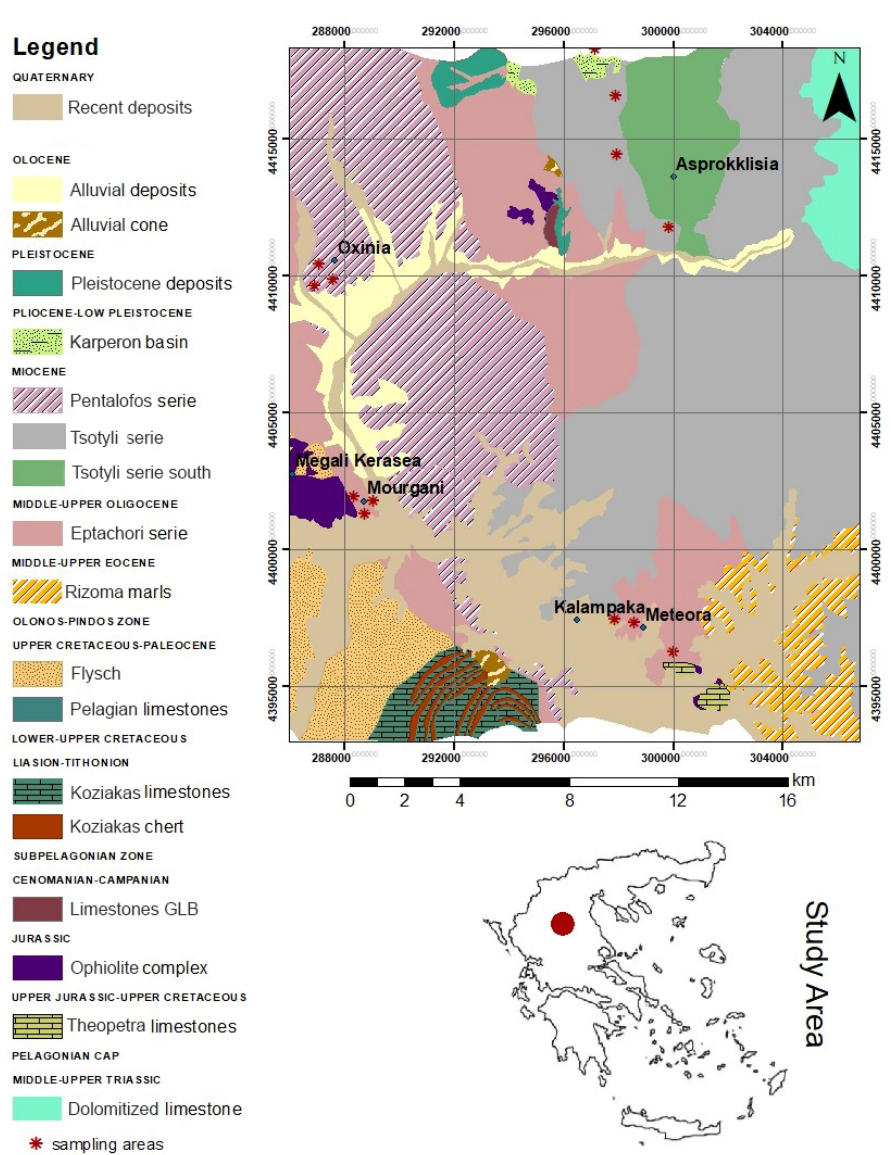
Figure 1. Geological map of the Southeast Mesohellenic Trough (northwest Greece) region (modified after fieldwork mapping).